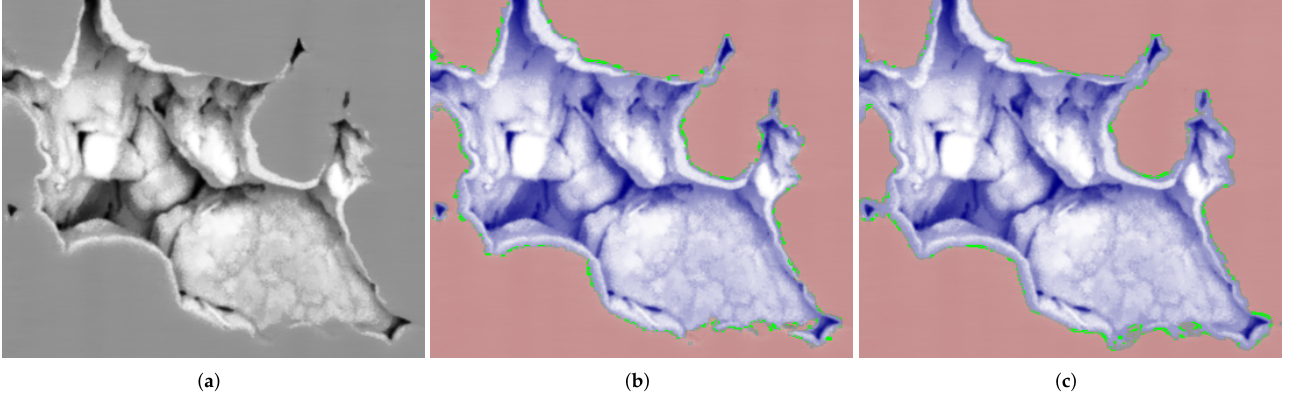
Figure 16. ( a ) Fragment of a slice from Figure 15; results of segmentation via ( b ) IPSDK and ( c ) Avizo: solid in red, pore space in blue, difference between repeatable and fast versions in green.